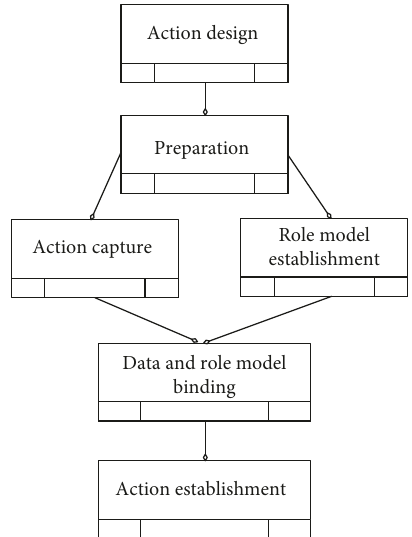
Figure 11: Workflow of the motion capture system for sports dance